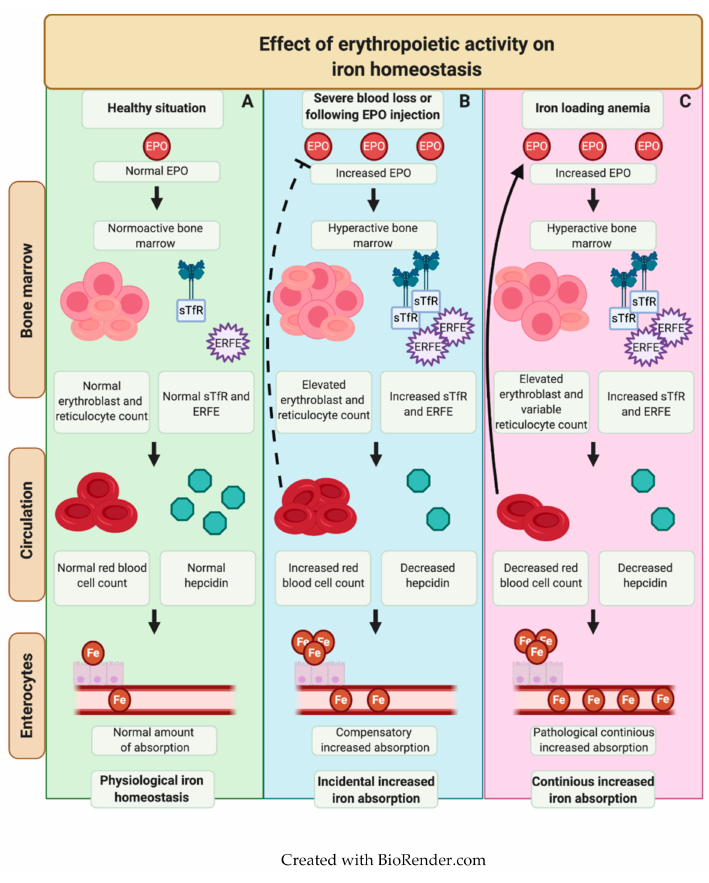
Figure 2. Simplified overview of connecting factors in erythropoiesis and iron metabolism. ( A ) Healthy situation. Normal production of red blood cells (RBCs) to prevent tissue hypoxia, ery- thropoietin (EPO) levels are low. erythroferrone (ERFE) levels are normal, little impact on iron metabolism. ( B ) Acute anemia or EPO injection. Low levels of oxygen lead to increased EPO levels. EPO stimulates erythroblast proliferation and maturation and subsequently upregulation of soluble transferrin receptor 1 (sTfr1) and ERFE levels. Hepcidin levels are suppressed via ERFE, allowing increased iron uptake, followed by incorporation in hemoglobin in erythroblasts. This results in an increase in RBCs and compensation for the anemia. ( C ) Iron loading anemia. This is characterized by ineffective erythropoiesis, resulting in suboptimal compensation for anemia, leading to a constitu- tively hyperactive bone marrow and a persistent increase in EPO and sTfR levels, with or without high reticulocyte numbers. Iron levels are sufficient to cover for erythroid demand. Hepcidin levels are persistently low, partially due to high ERFE levels, leading to iron